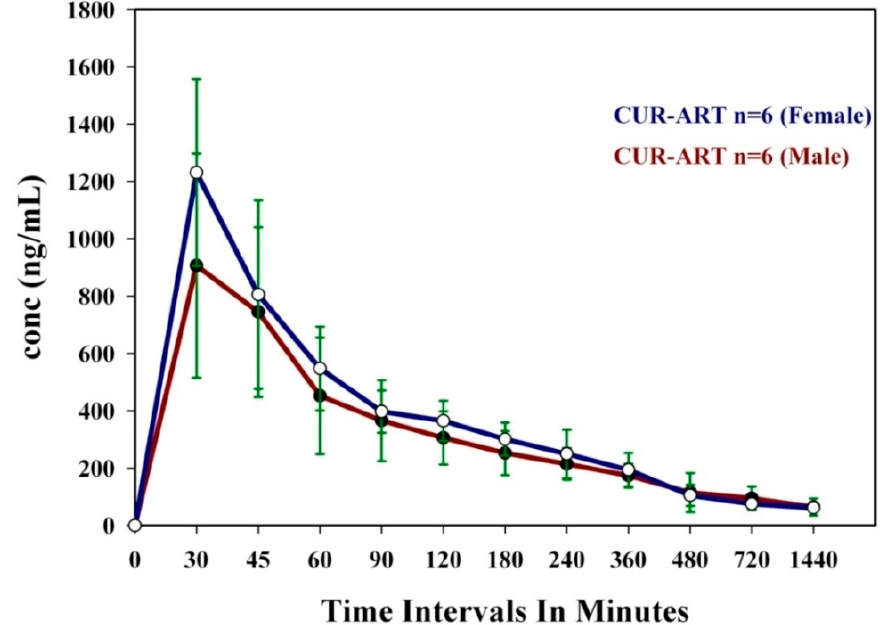
Figure 4. Mean Plasma concentration of CUR-ART coamorphous vs. Time profile obtained from both female and male SD rats.